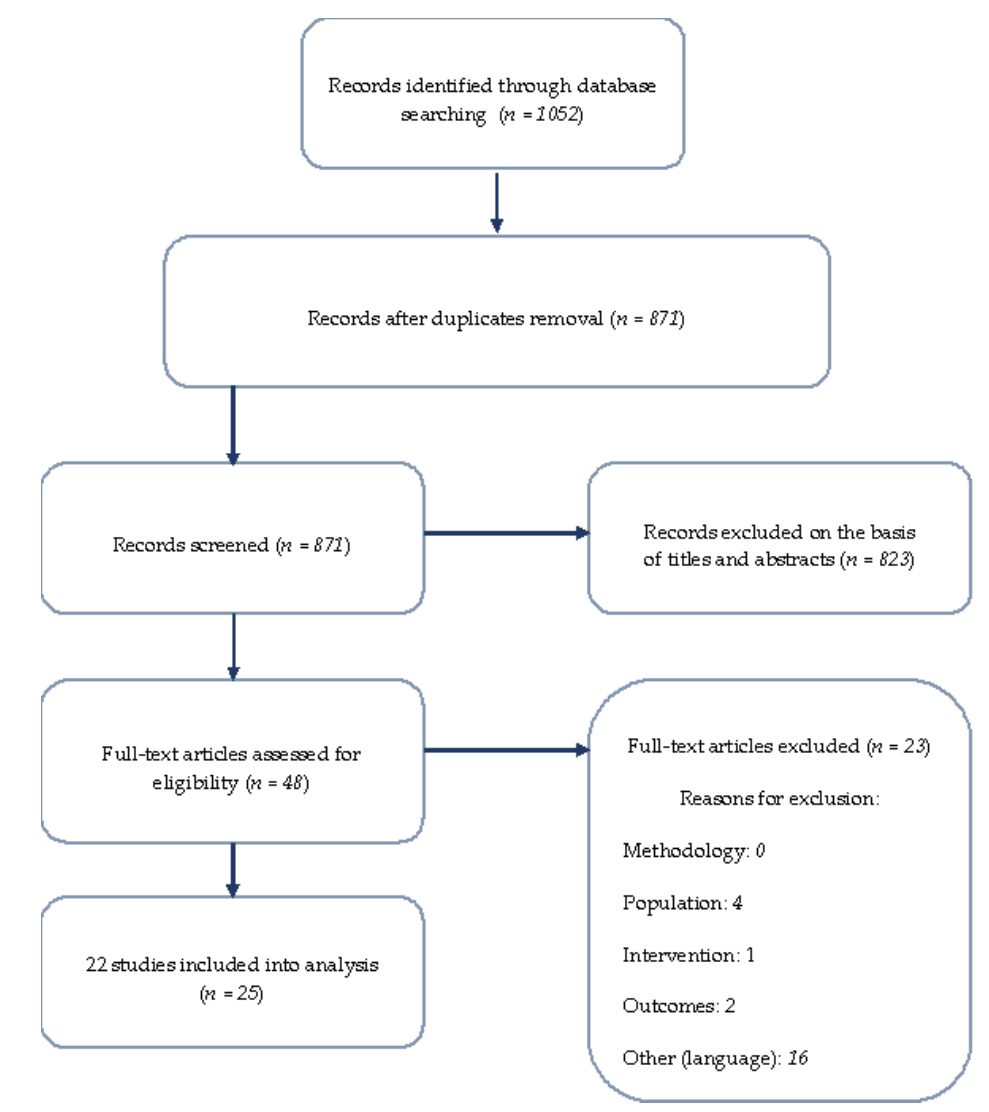
Figure 1. Flow chart of literature search strategy according to PRISMA.